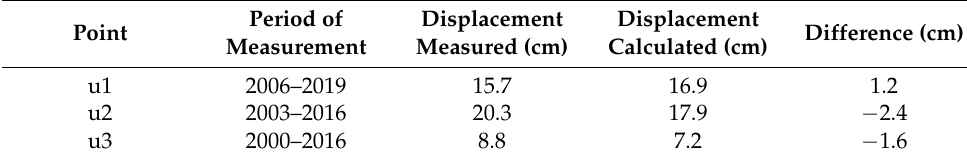
Table 4. Comparison of calculated and measured data for 3 example points for horizontal displace-